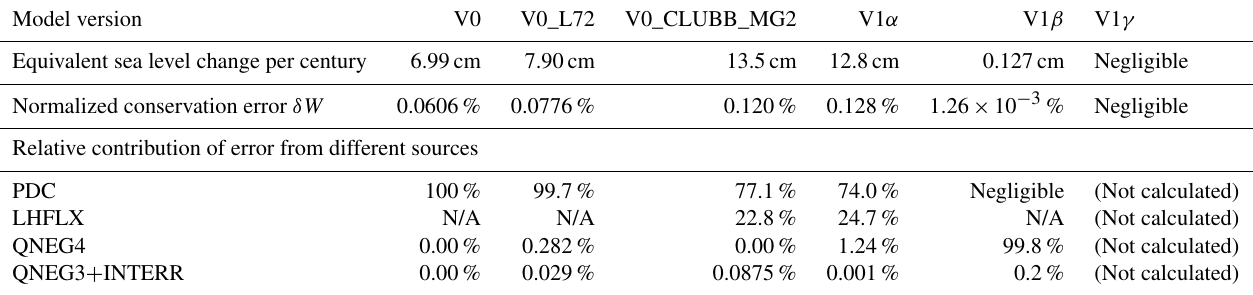
Figure 3. Water conservation error in 5-day simulations conducted using different configurations of the E3SM V0 and V1 model at 1 ◦ (ne30) resolution. The errors are shown as the estimated sea level change (cm) per century, calculated using Eq. (6) at each model time step. The y axes in (e) and (f) use scales different from the rest of the figure. The model configurations are summarized in Table 2. The definition of individual sources of water conservation error can be found in Sect. 3. Table 3. Water conservation error in the 5-day atmosphere-only simulations with EAM V0 and V1 model configurations. The equivalent sea level change is calculated using Eq. (6). The normalized conservation error is calculated using Eq.